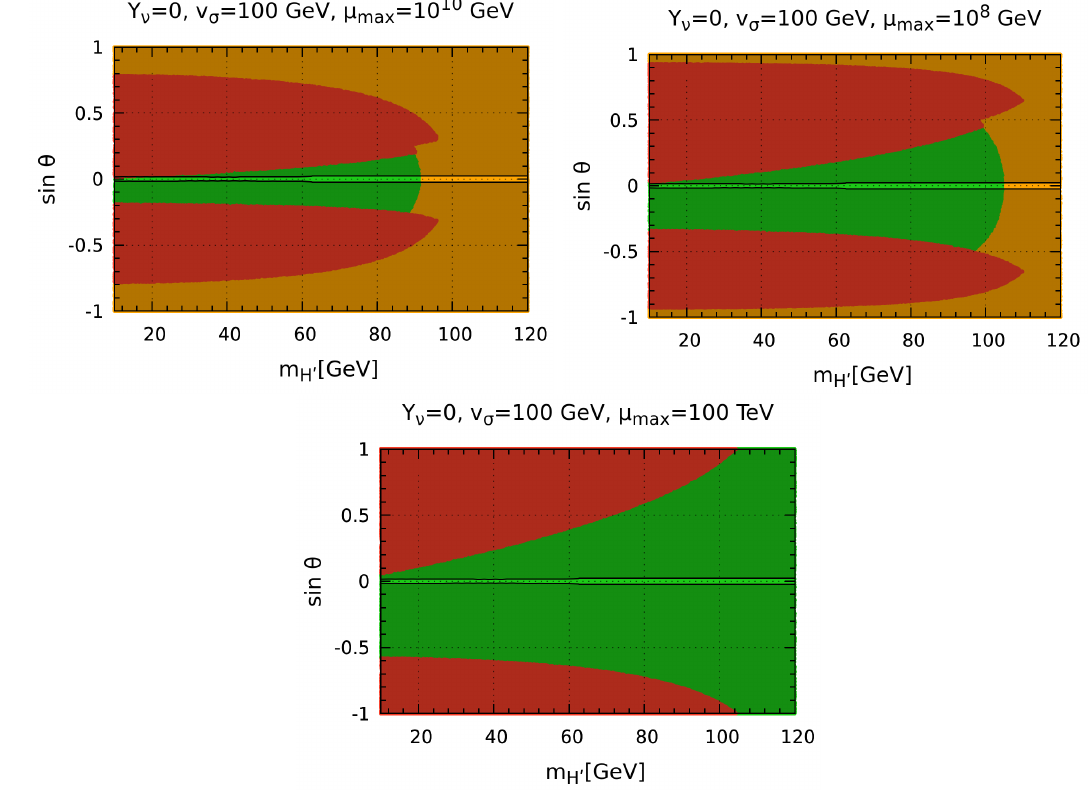
Figure 14 . Same as in figure 12 but now we have considered RGEs evolution only up to µ max = 10 10 GeV (upper left panel), 10 8 GeV (upper right panel) or 100 TeV (lower